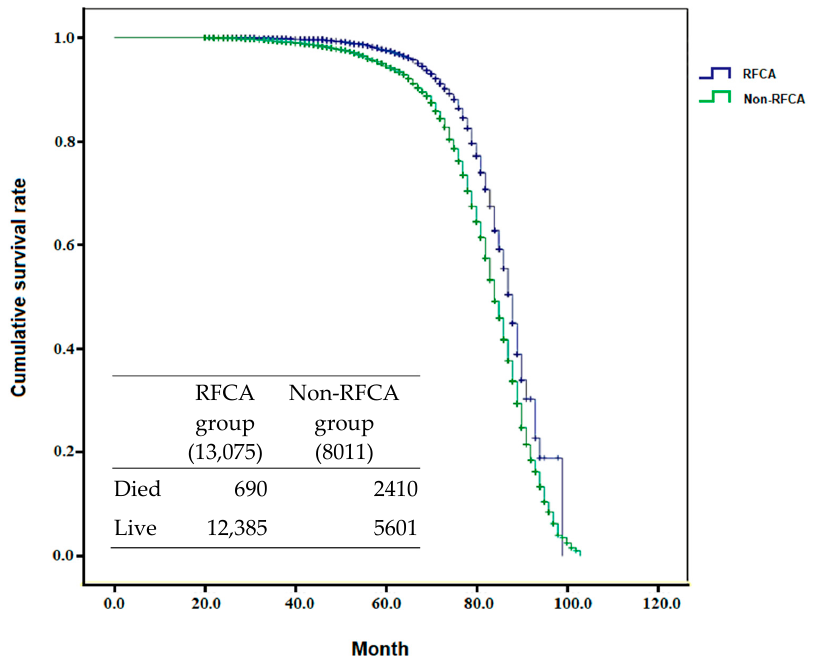
Figure 5. Cumulative survival rate in the two groups ( p < 0.0001).